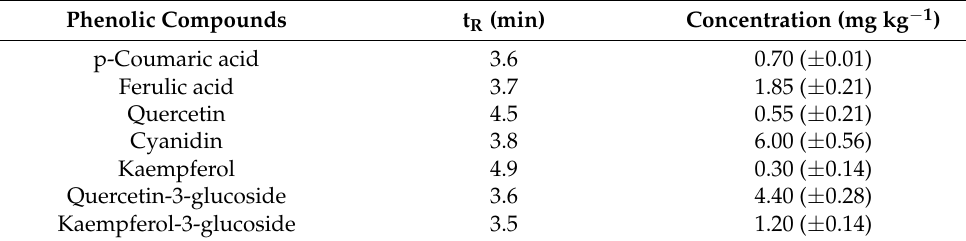
Table 5. Main phenolic compounds identified in the extracts obtained at the optimal UAE conditions by UHPLC-ESI+-Orbitrap-MS